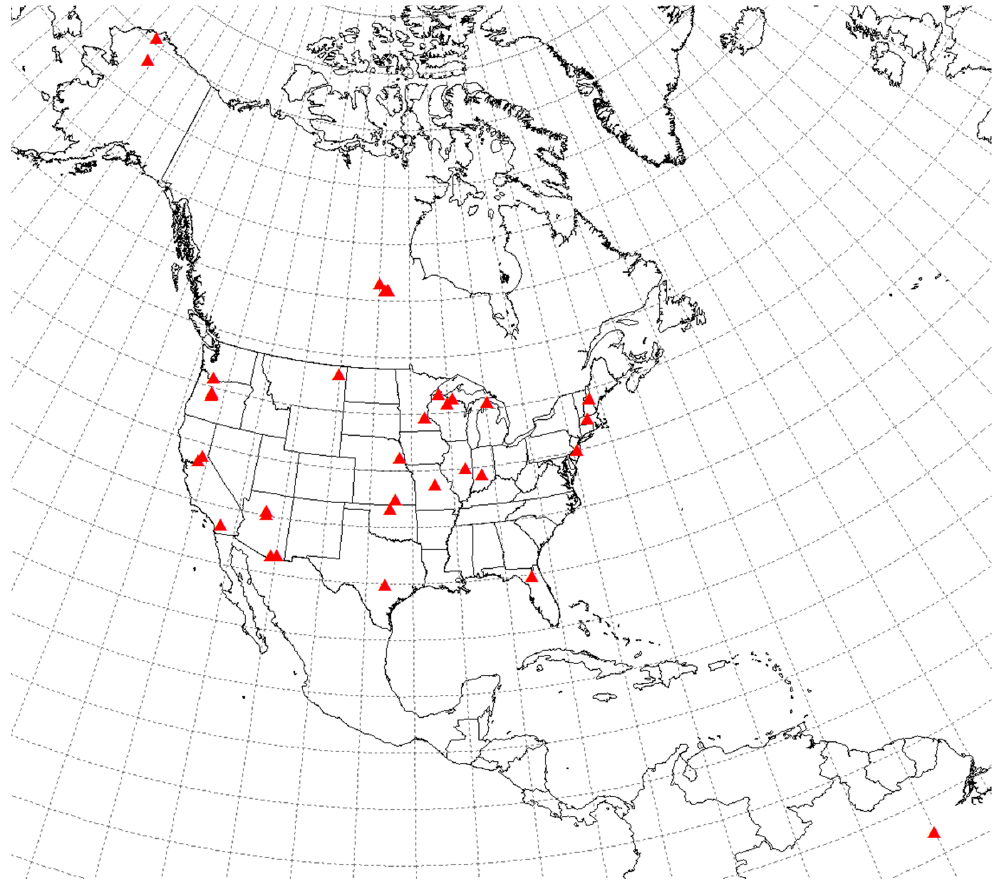
Figure 4. Locations of the AmeriFlux Eddy Covariance tower sites using in this study.